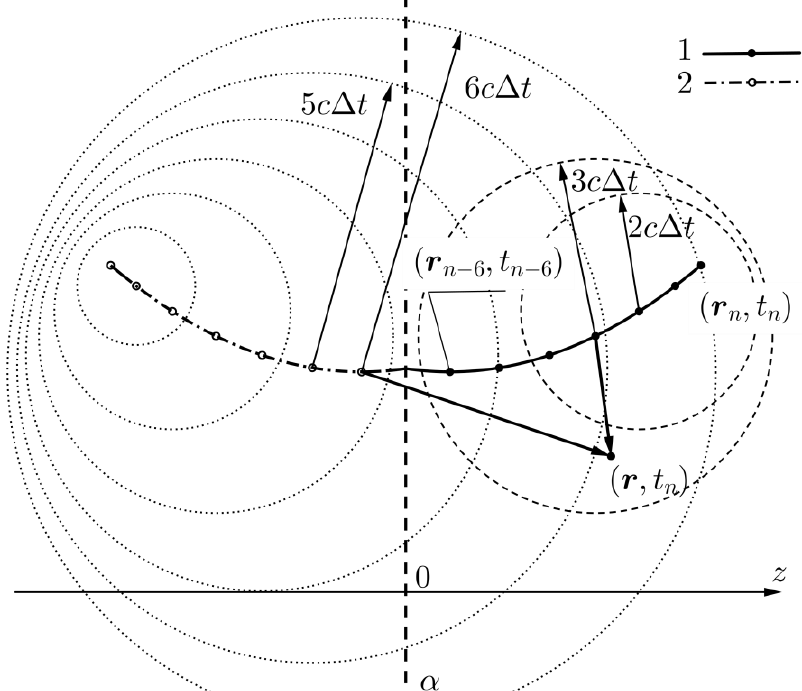
Fig. 3. The method of images for charged particles above the conducting plane α . The field at this point is the sum of the fields of the original 1 and image 2, they are determined by the Lienar- Wiechert formulas with the calculation of the time in the past by the bisection